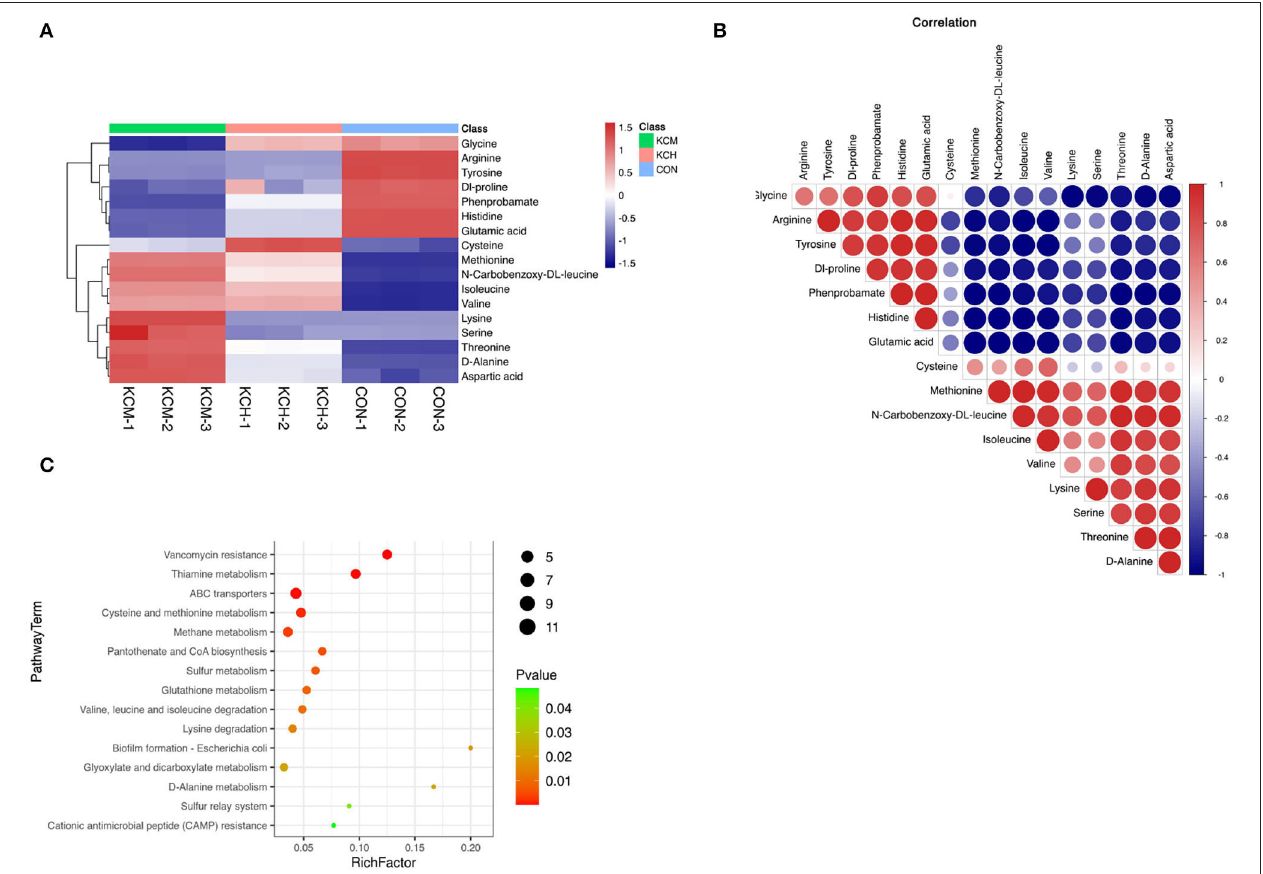
FIGURE 12 | Analysis of different amino acid metabolites in the bacterial culture supernatant. The hierarchical clustering of the top 50 differential metabolites expression in the bacterial culture supernatant (A) , the correlation analysis of differential metabolites (B) , and the enrichment analysis of differential metabolite pathways (C)